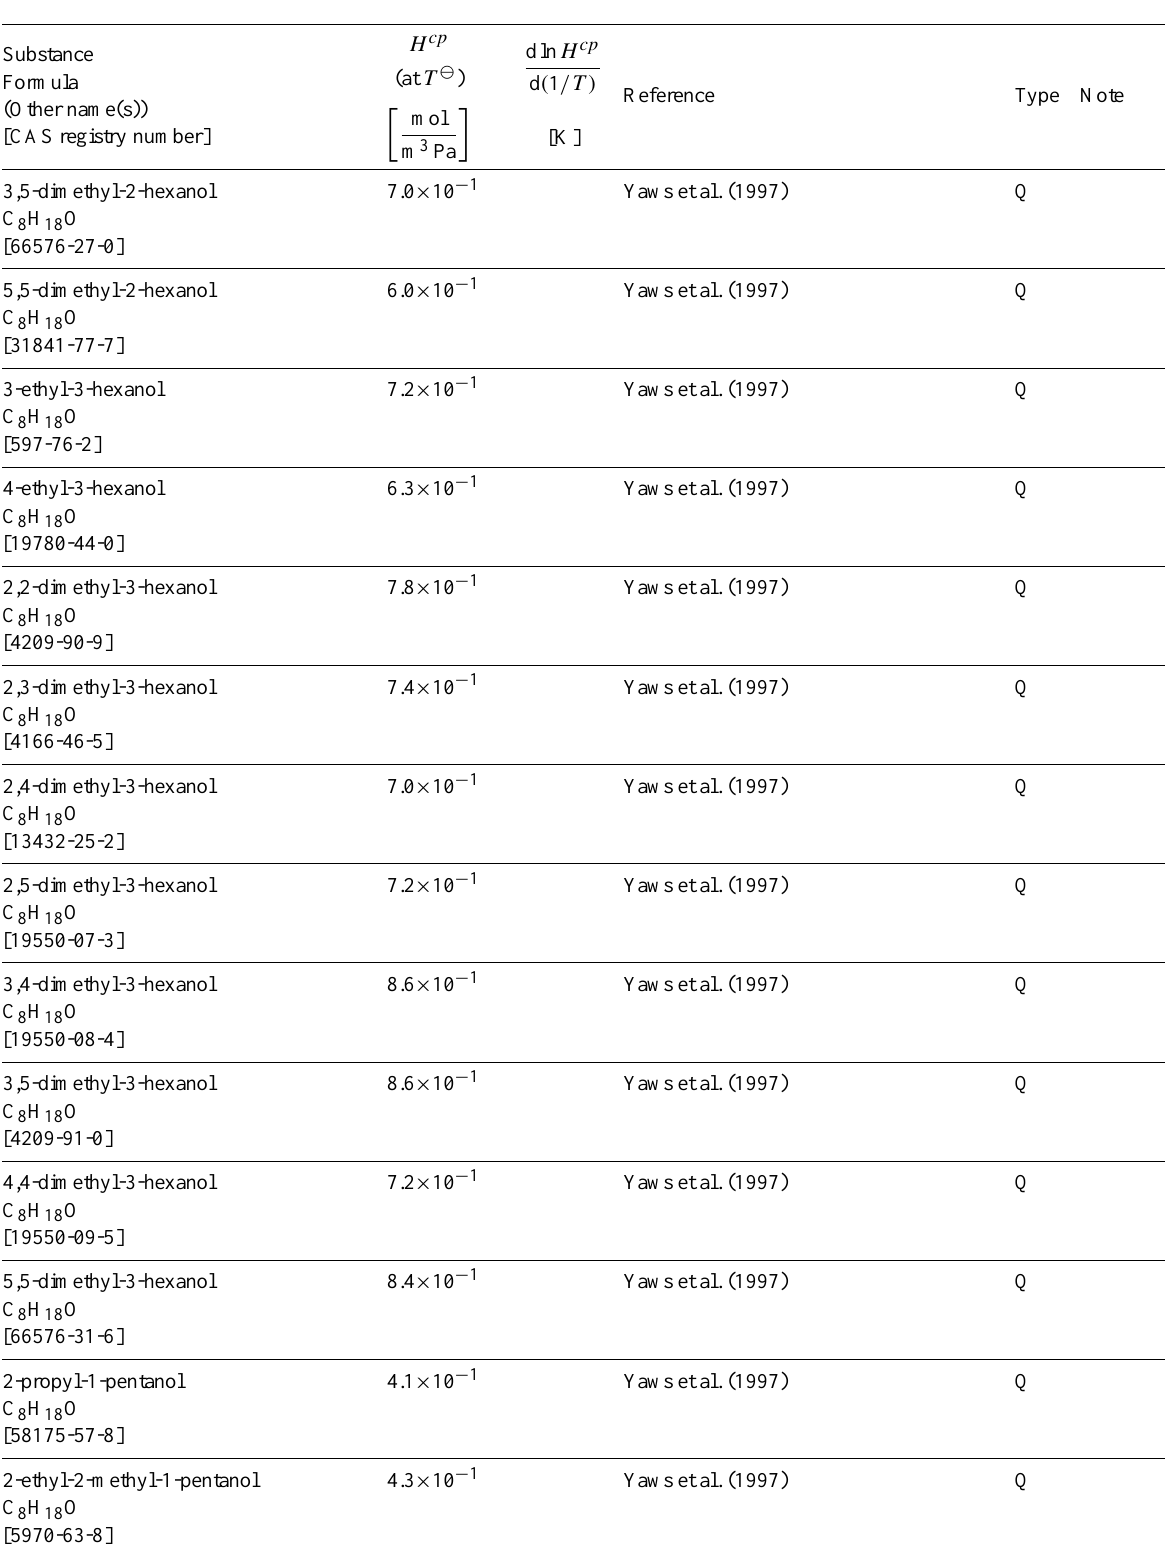
Table 6: Henry’s law constants for water as solvent